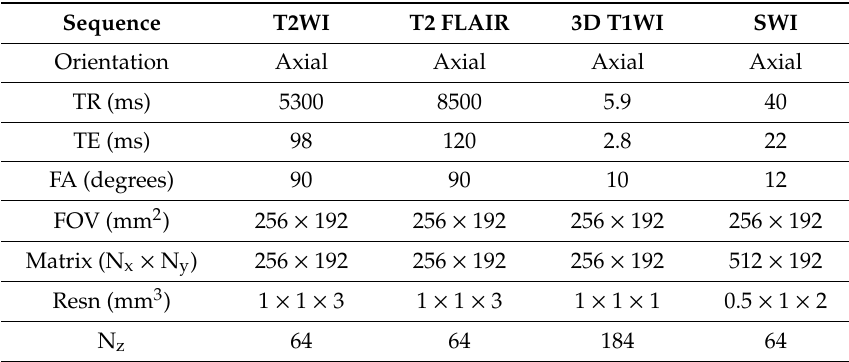
Table 2. Imaging parameters for the sequences used for cohort